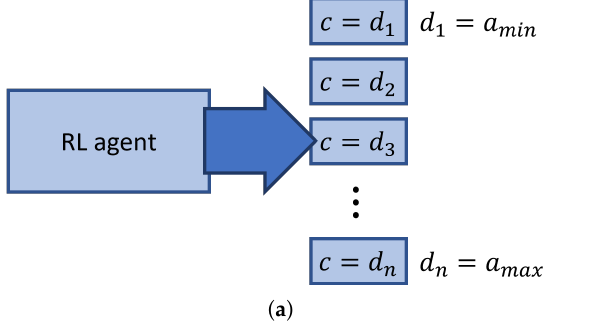
Figure 5. Two ways to control continuous action signals, c (cid:101) [ a , b ] , using an RL agent with n discrete output steps. Table 4. RL-based powertrain control studies, the action continuity of their chosen RL algorithm(s), and the native continuity of the actuator(s) being